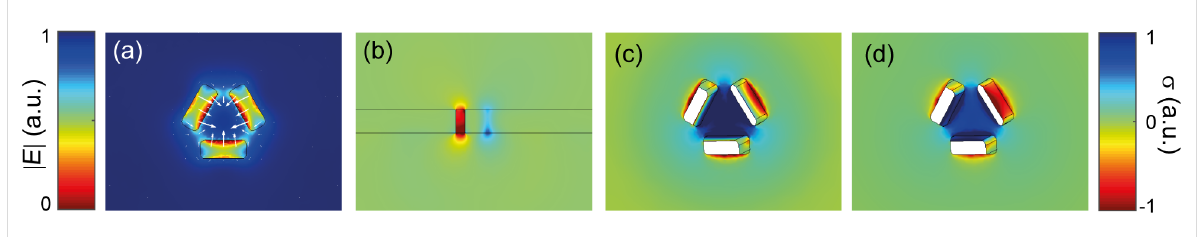
Figure 5: Electric field inside a trimer of rectangular slots of length 100 nm and width 40 nm in a gold film of thickness 100 nm at a wavelength of 690 nm excited by an electric dipole located 30 nm above the upper surface of the film and centred above the structure. The magnitude of the electric field (arrows showing direction) a distance of 5 nm above the lower surface of the gold film is shown in (a), while (b) shows the vertical component of the electric field in a vertical plane with reference to the geometry shown in (a). The (instantaneous) surface charge density on the metal boundary at a wavelength of (c) 580 nm and (d) 690 nm is also